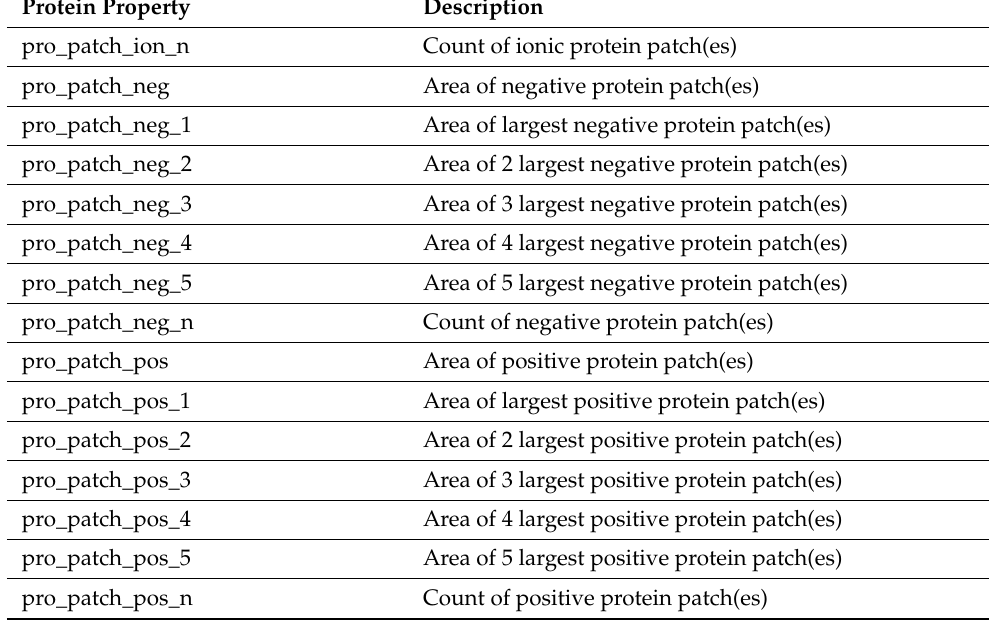
Table 1. Cont. Protein